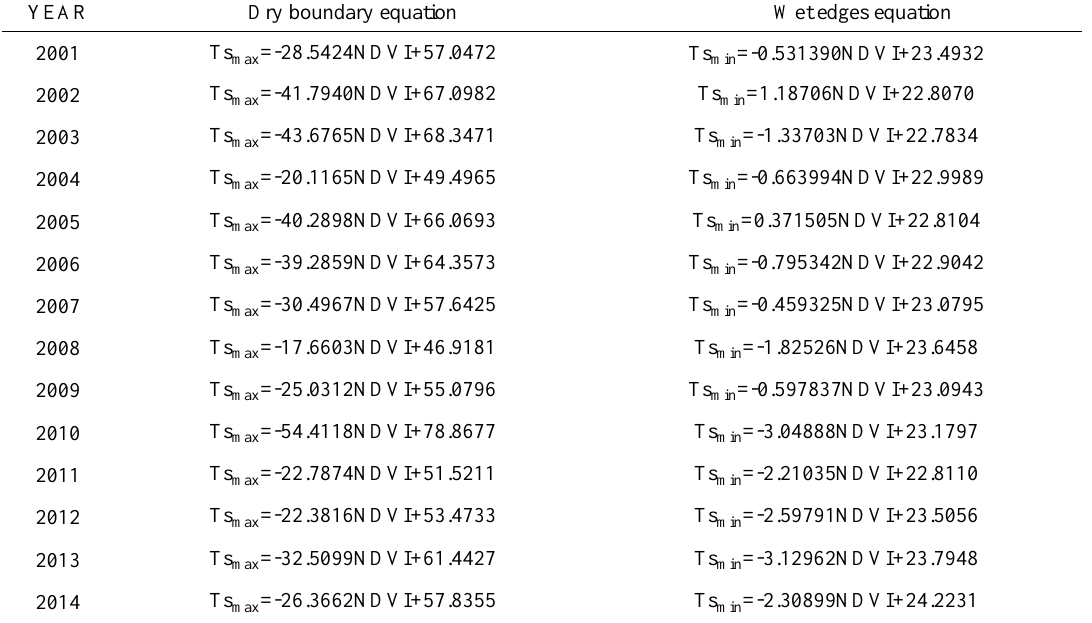
Table 2. NDVI-Ts characteristic space dry-wet edge equation in Beijing-Tianjin-Hebei region from 2001 to